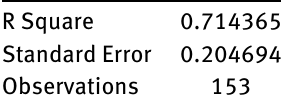
Table 8: Results of fuzzy logic ROP